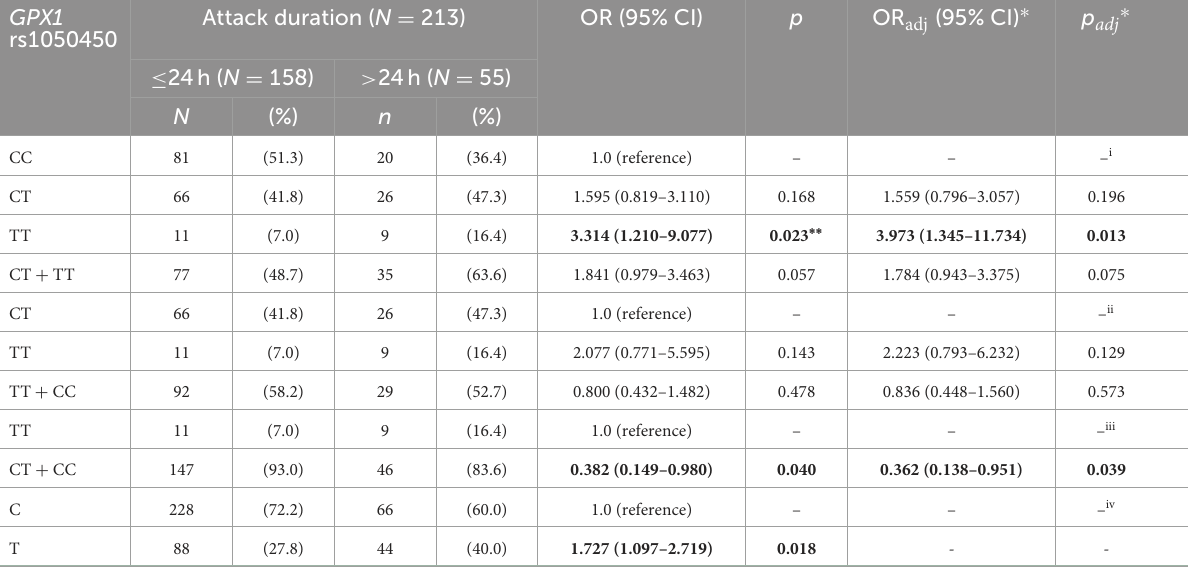
TABLE 6 Genotypic and allelic frequency distribution analysis of the GPX1 rs1050450 variant in migraineurs according to the typical duration of migraine attacks ( ≤ 24 vs. >